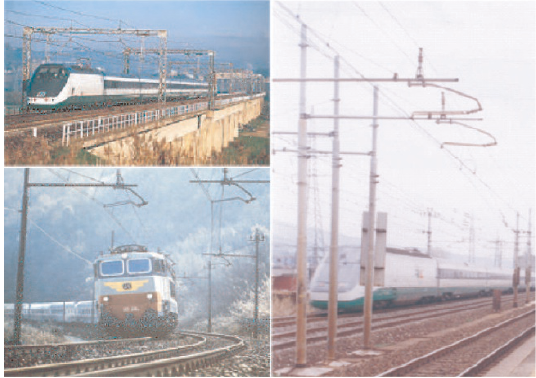
Figure 1: Nomenclature of railway specific